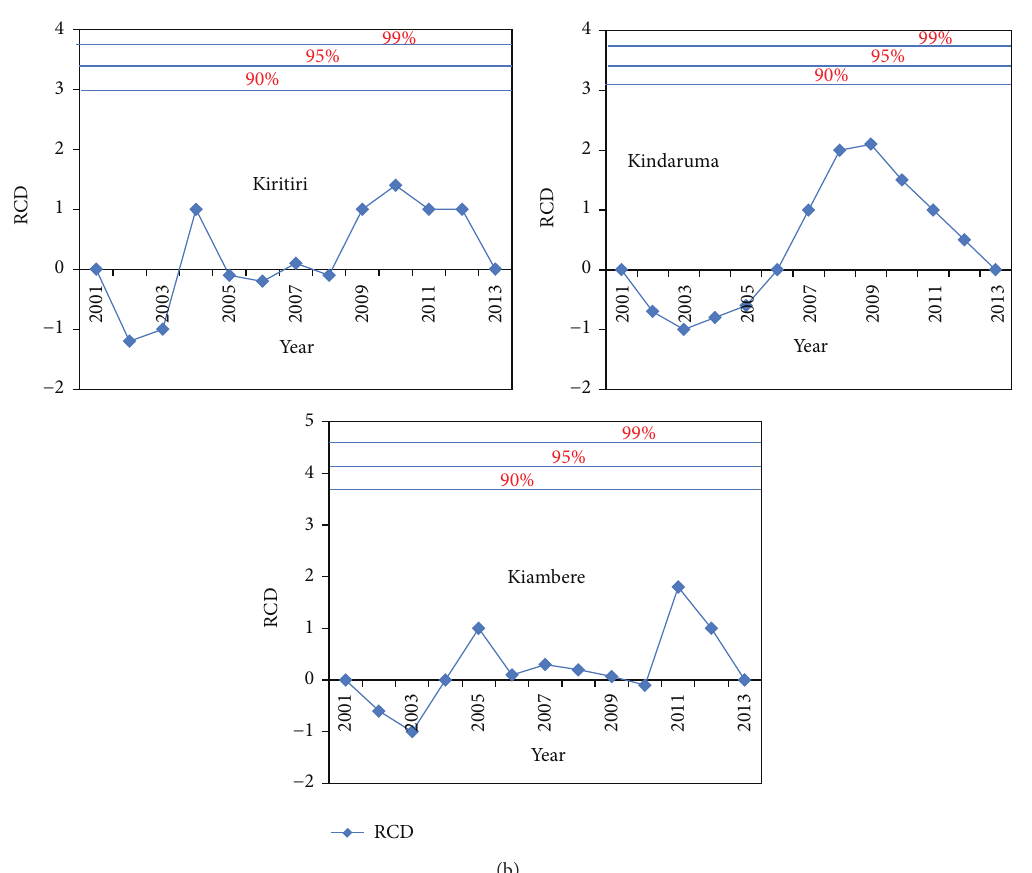
Figure 3: Rescaled cumulative deviations for seasonal months and studied rainfall stations for the period between 2000 and 2013. Table 3: (a) Homogeneity test for the rainfall dailies from study stations for the period between 2000 and 2013. (b) Seasonal monthly (K-S value), mean, and standard deviation and 𝑅 2 values for average rainfall dailies in both Mbeere region and Embu for the period between 2001 and 2013. (a)